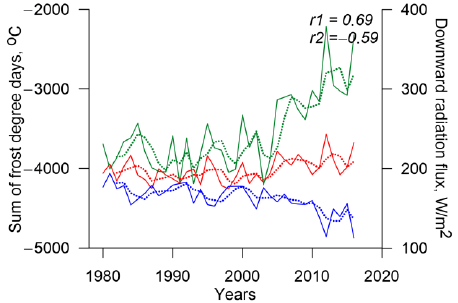
Figure 3. Interannual variation of the sum of degree days of frost in October – April (green), downward long-wave radiation (red), and the thickness of fast ice in April (blue) in the Kara Sea from 1979 to 2019. Dotted line — after smoothing with 3-year window, r1 — correlation coefficient between green and red series after removal of the trend; r2 — correlation coefficient between green and blue series after removal of the trend.